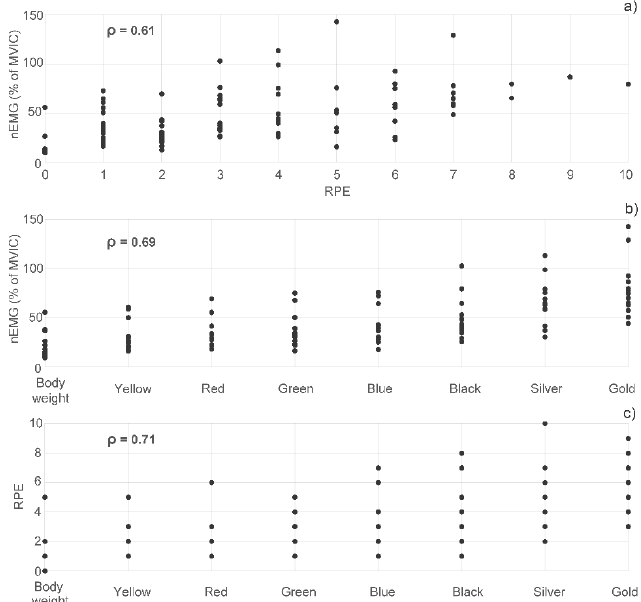
Figure 6. Correlation analysis. The circles represent the nEMG (average value of the three muscles) vs. RPE ( a ), the nEMG vs. the level of intensity ( b ) and the RPE vs. the level of intensity ( c ).